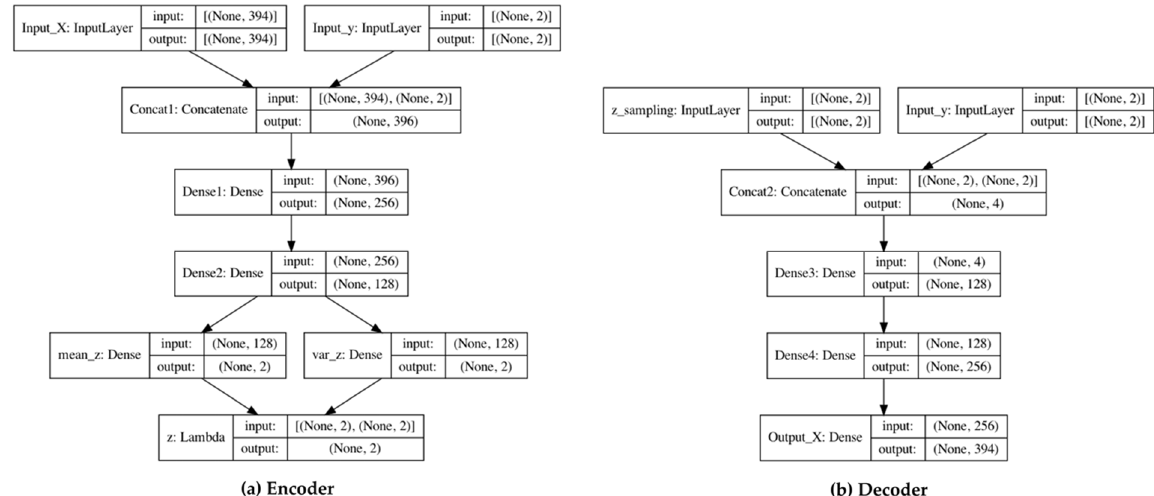
Figure A1. Architecture of the generative model used in the experiment. ( a ) An encoder of the generative model receives 10 quantitative indicators and embedding vectors for 384-dimensional natural language and returns a 2-dimensional latent vector; ( b ) the decoder generates